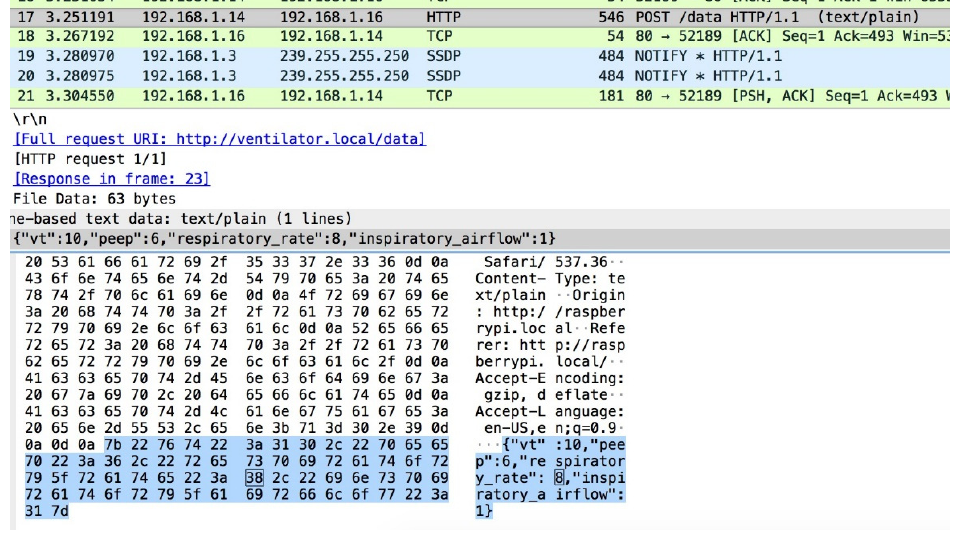
Figure 11. The capture of values under the normal scenario.